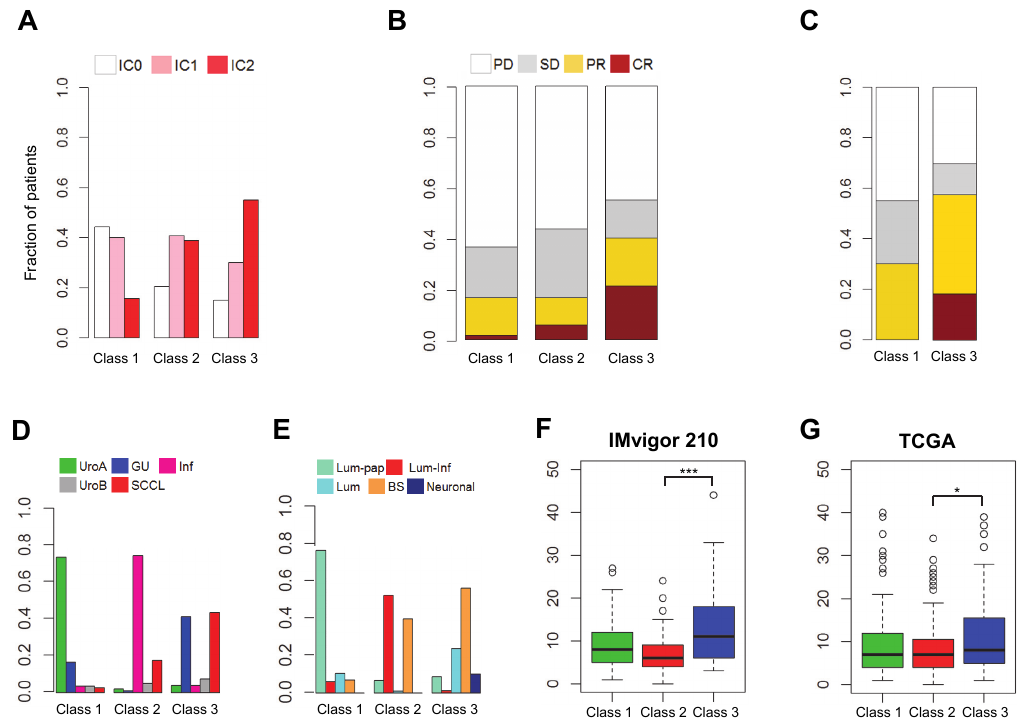
Figure 2. Clinical and biological characteristics of Figure 1A. ( A ) Distribution of PD-L1 protein expression levels on immune cells in each class ( p = 0.0003 by the chi-squared test). ( B ) Objective response rate stratified by the three subgroups ( p = 2.714 × 10 − 5 by the chi-squared test). ( C ) Comparison of the objective response rate between class 1 and class 3 in the GU subtype of the Lund classification ( p = 0.046 by the two-tailed Fisher’s exact test). PD, progressive disease; SD, stable disease; PR, partial response; CR, complete response. ( D ) Distribution of subtypes of the Lund classification in each subgroup ( p < 2.2 × 10 − 16 by the chi-squared test). UroA, urothelial-like A; GU, genomically unstable; Inf, infiltrated; UroB, urothelial-like B; SCCL, squamous cell carcinoma-like. ( E ) Distribution of subtypes of the TCGA classification in each subgroup ( p < 4.6 × 10 − 51 by the two-tailed Fisher’s exact test). Lum-pap, luminal-papillary; Lum-inf, luminal-infiltrated; Lum, luminal; BS, basal squamous. ( F ) Reported tumor mutation burden (TMB) classified by the three subgroups ( p = 1.83 × 10 − 8 by the two-sample t -test). ( G ) Reported TMB, classified by the three subgroups in the TCGA cohort ( p = 0.012 by the two-sample t -test; class 2 vs. class 3). * p < 0.05, *** p < 0.001.